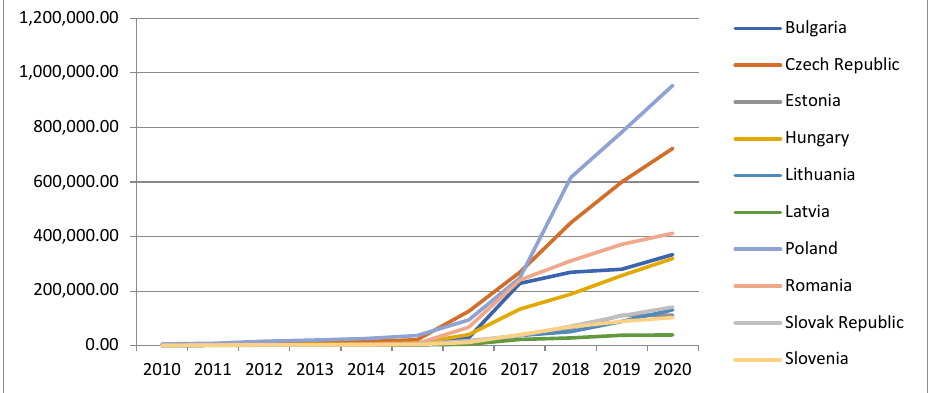
Figure 5. Evolution of credit cards (CC) and debit cards (DC). If we analyze the developments related to debit and credit cards in selected European countries, we can cite a disjointed market. We also observed that these differences be- tween countries were accentuated during the pandemic, which led us to wonder what their effects were on the performance of the banking systems. The two graphs above (Figure 5) clearly show the dominance of debit cards in the CEECs, a fact that can be partially explained by the position among banks in the analyzed countries that any current account should be accompanied by a card. Another explanation